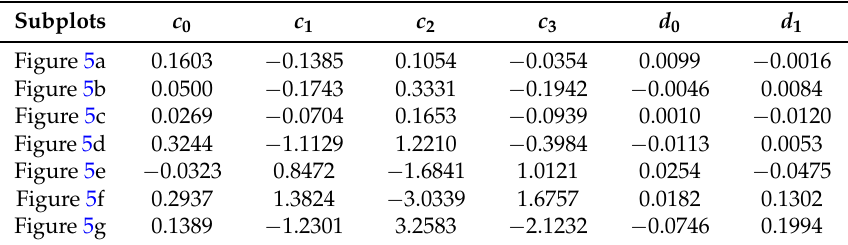
Figure 5. Battery model parameters at 0.5C: ( a ) internal resistance, R 0 ; ( b ) polarization resistance, R 1 ; ( c ) polarization resistance, R 2 ; ( d ) polarization resistance, R 3 ; ( e ) polarization capacitance, C 1 ; ( f ) polarization capacitance, C 2 ; ( g ) polarization capacitance, C 3 . Table 5. Parametric equation coefficients of the solid lines in Figure